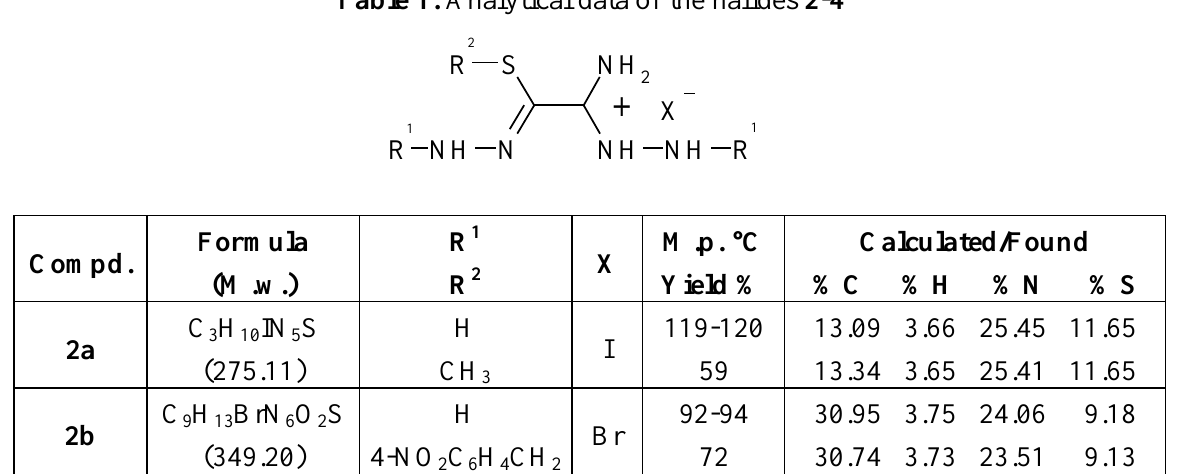
Table 1. Analytical data of the halides 2 -